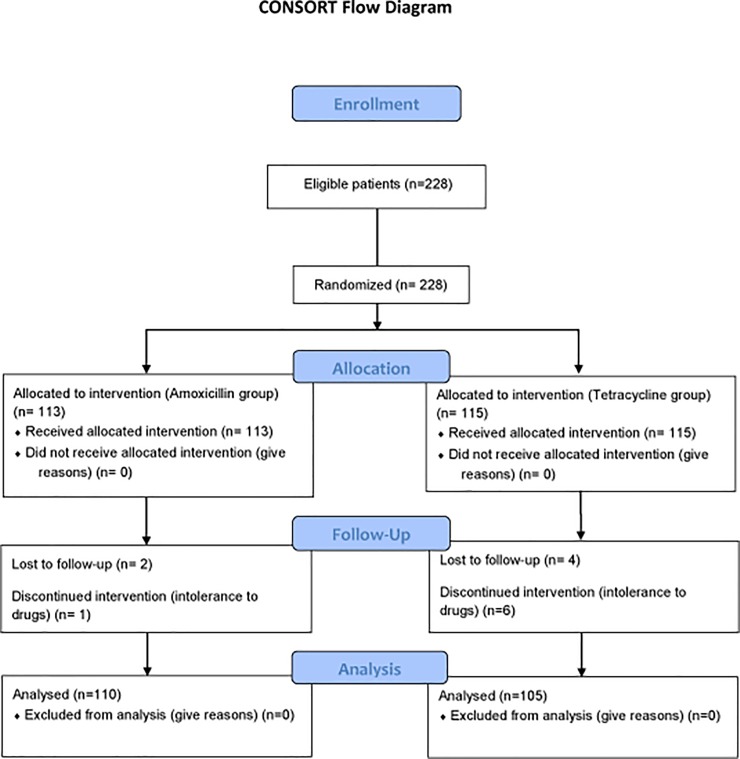
CONSORT flow diagram.